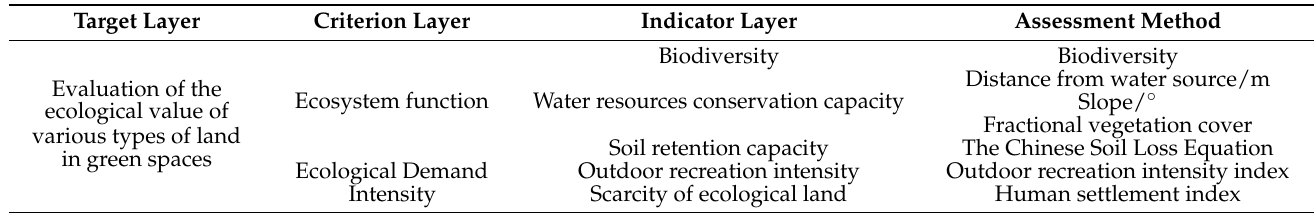
Table 1. Evaluation index of the ecological value of urban land